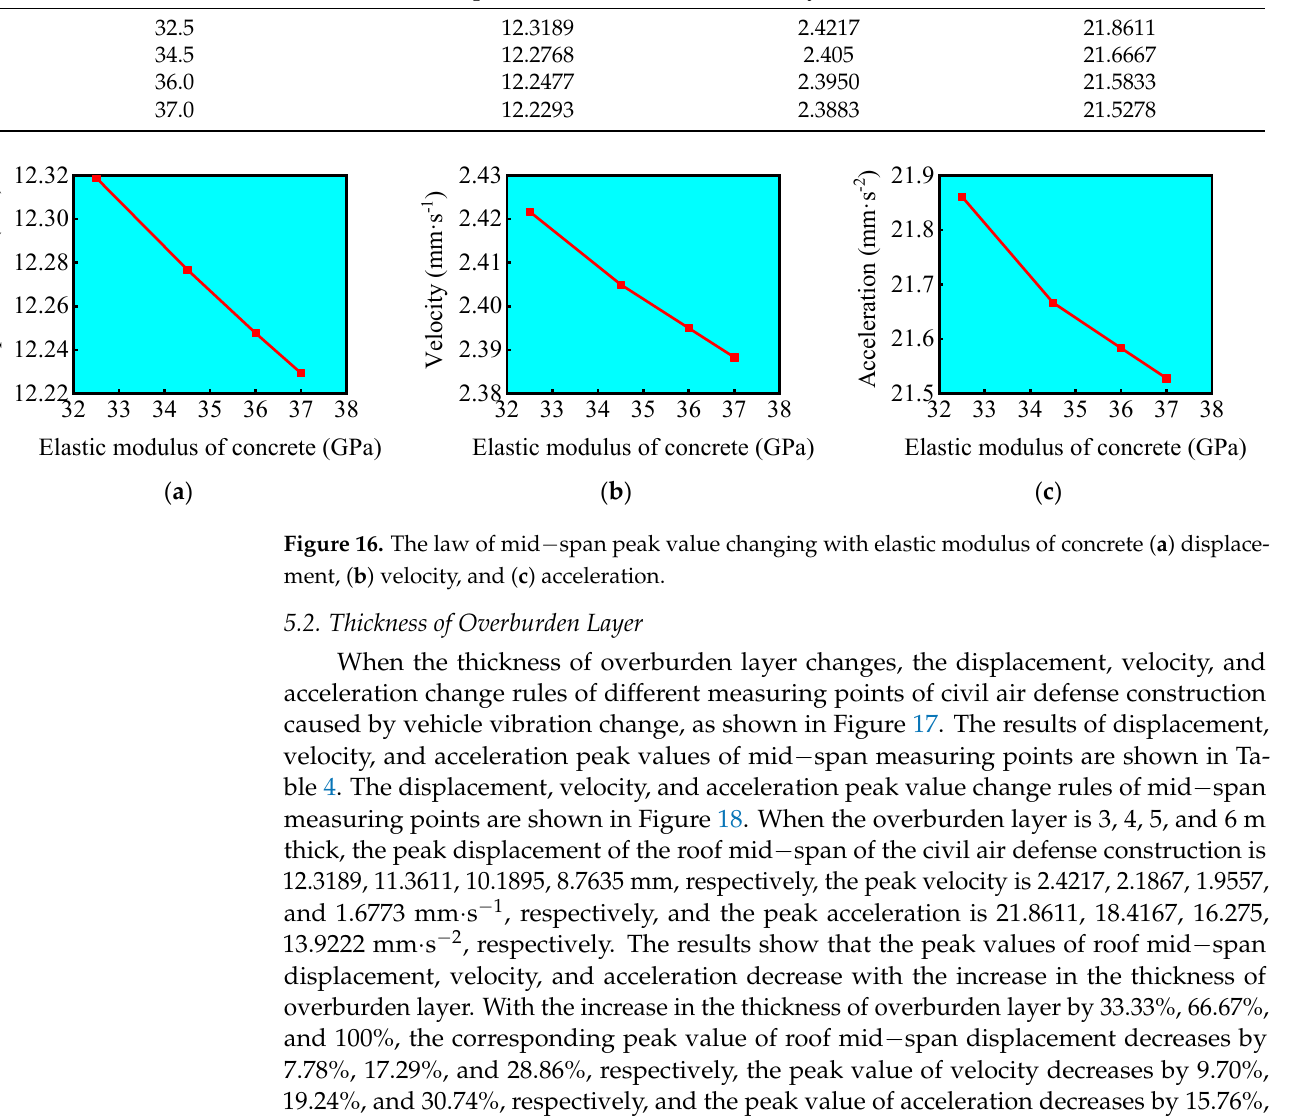
Figure 15. Peak value variation rule of different measuring points when the elastic modulus of con- crete changes ( a ) displacement, ( b ) velocity, and ( c ) acceleration.